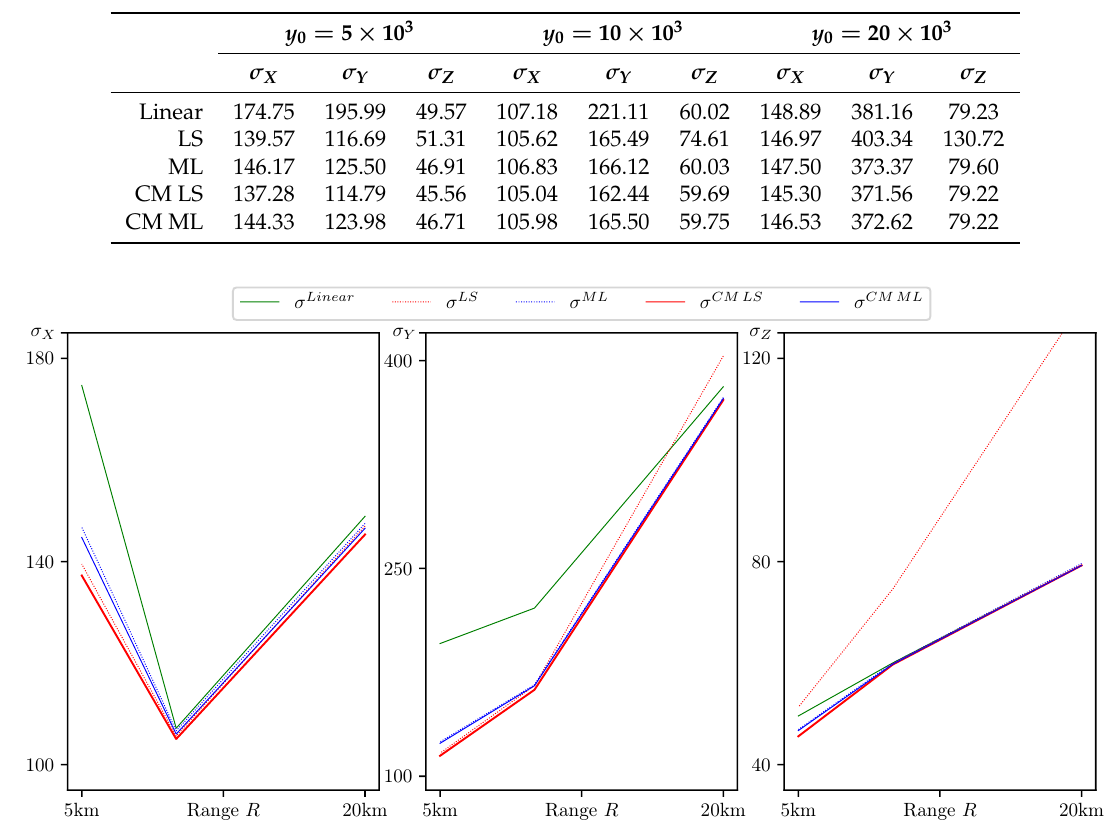
Table 1. Coordinate-wise std of estimation error σ E for E ∈ { Linear, LS, ML, CM LS, CM ML } .